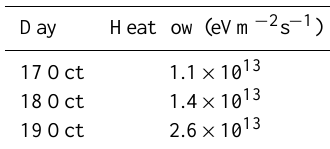
Fig. 7. Rise time as a function of heater frequency, observed values plotted as comparsion. Inset is zoomed in on modeled times. Table 2. Heat flow used in